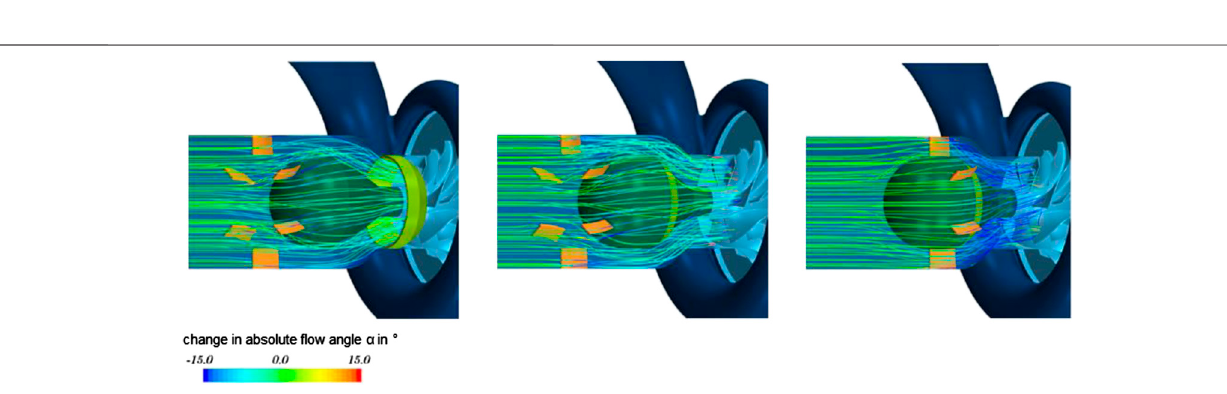
FIGURE9| Conceptforcombiningcounter-swirl, fl ow-bodyandcone;in fl uenceonthein fl owbehavior.Intheleftisforlow,inthemiddleformediumandintheright for high compressor mass fl